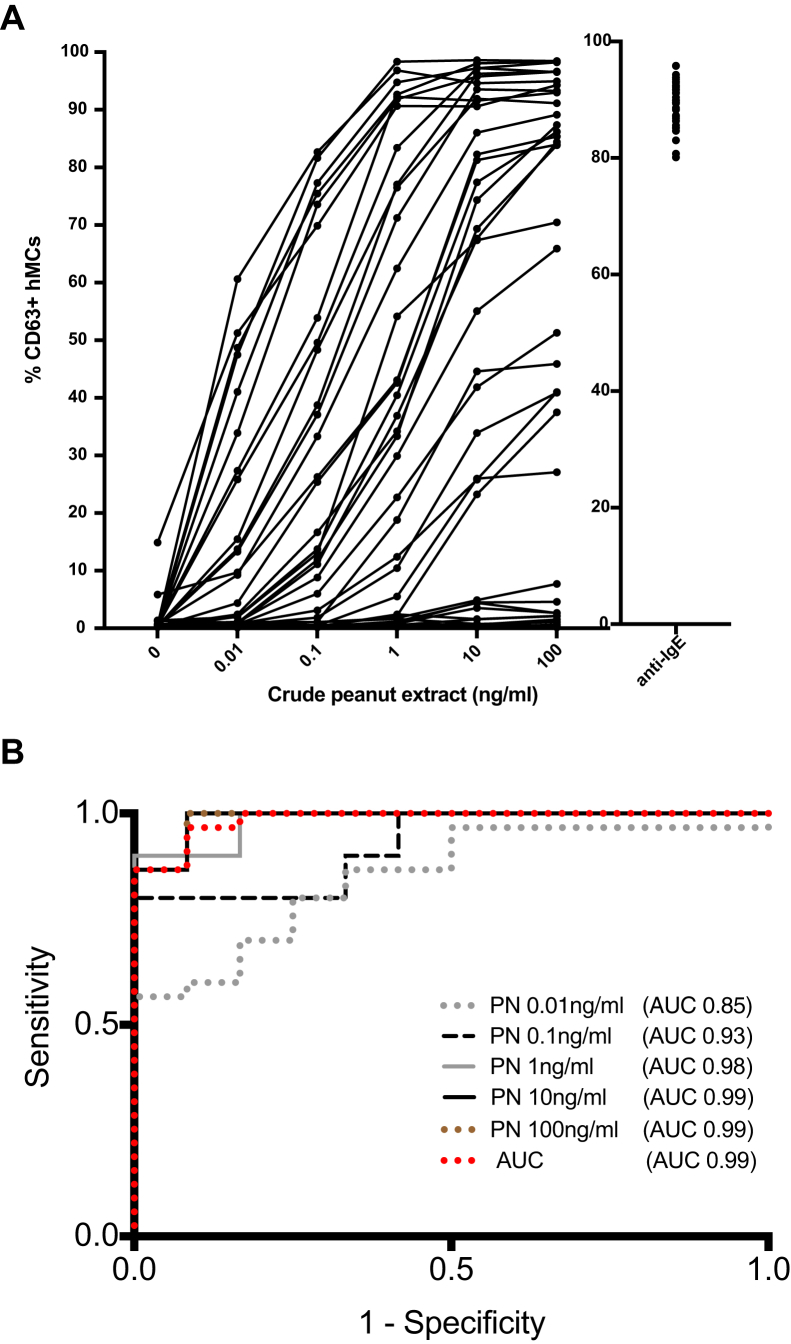
hMC degranulation in peanut-sensitized patients from the validation cohort (n = 42). A, hMCs were sensitized overnight with patients' sera, washed, and then incubated with varying concentrations of peanut extract (as indicated) or anti-IgE (10 μg/mL) for 1 hour. hMC degranulation was measured based on CD63 surface expression by using flow cytometry. B, Corresponding ROC curve. AUC, Area under curve; PN, peanut.